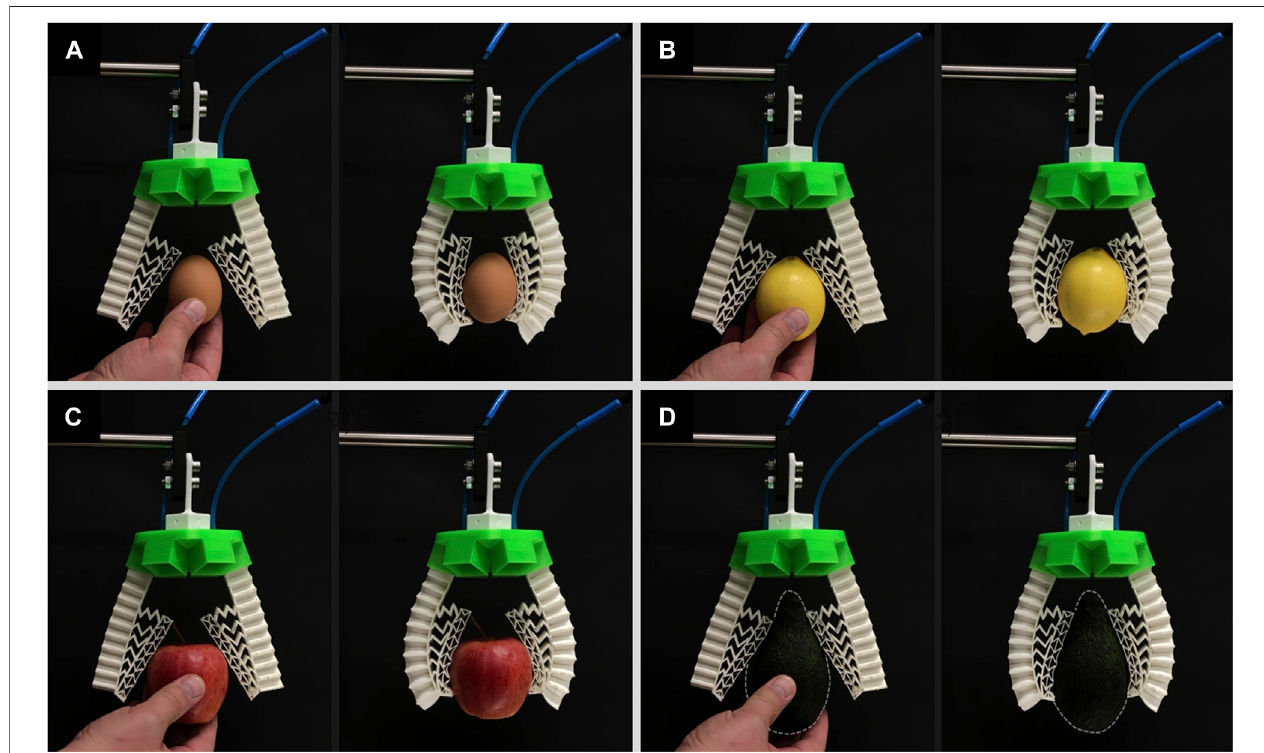
FIGURE 8 | The soft modular gripper in a two- fi nger con fi guration with the mechanical metamaterial grasping successfully (A) an egg, (B) a lemon, (C) an apple, and (D) an avocado.